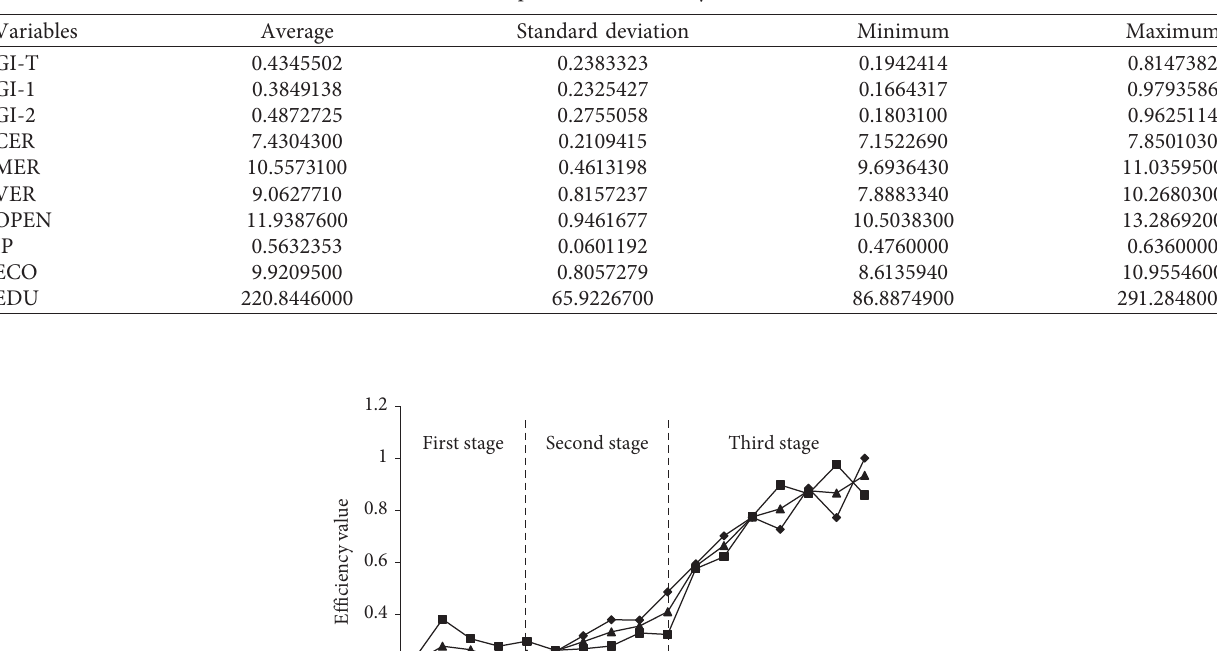
Table 3: Descriptive statistical analysis of variables.